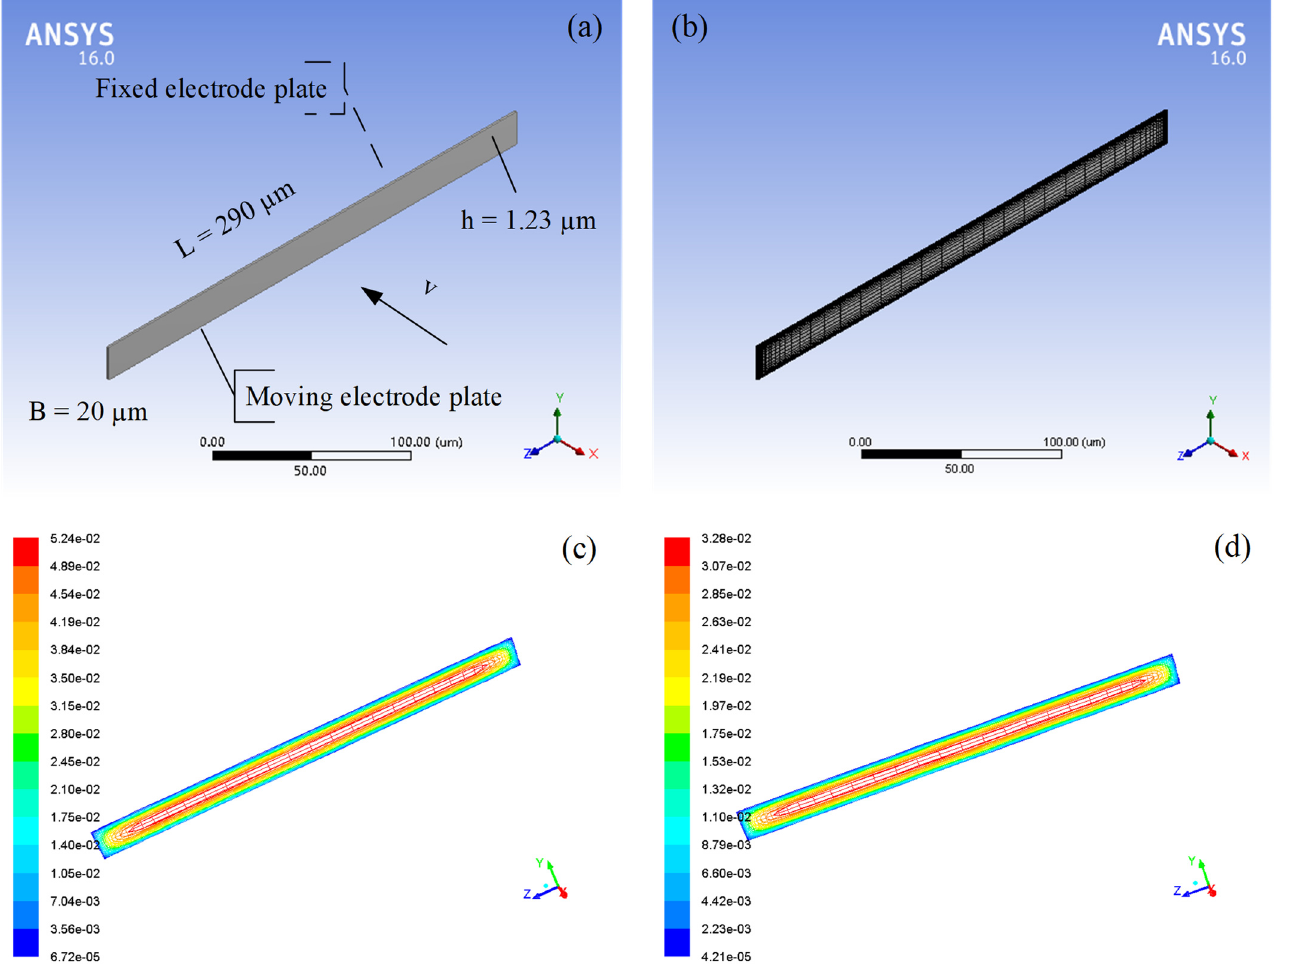
Figure 7. ( a ) Physical model and ( b ) meshing model of squeeze-film air damping between the fixed electrode plate and the moving electrode plate in the micro-accelerometer; the air pressure distributions between the fixed electrode plate and the moving electrode plate when the air pressure is ( c ) 12,400 Pa and ( d ) 1243 Pa. Table 3. Simulation parameter settings under low